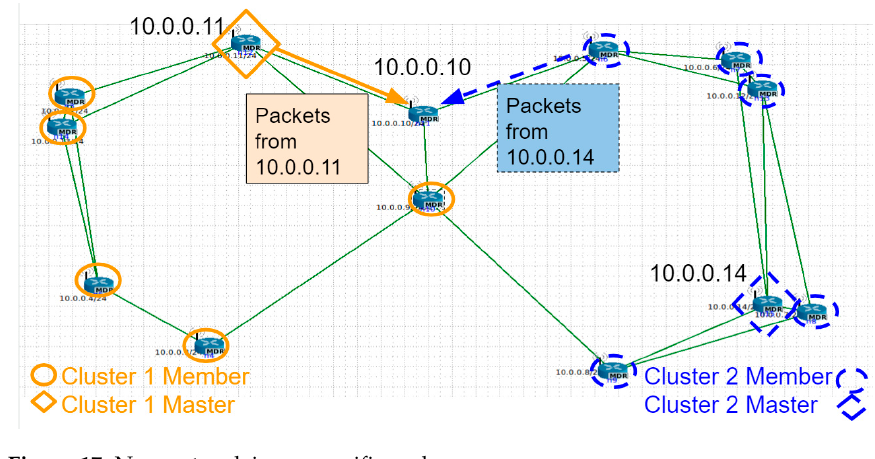
Figure 17. No master claims a specific node.